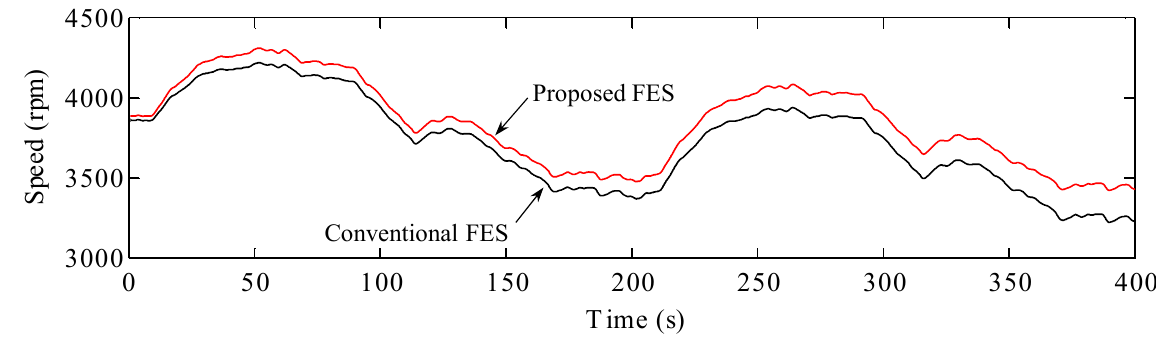
Figure 8. Stator powers of the FES systems.